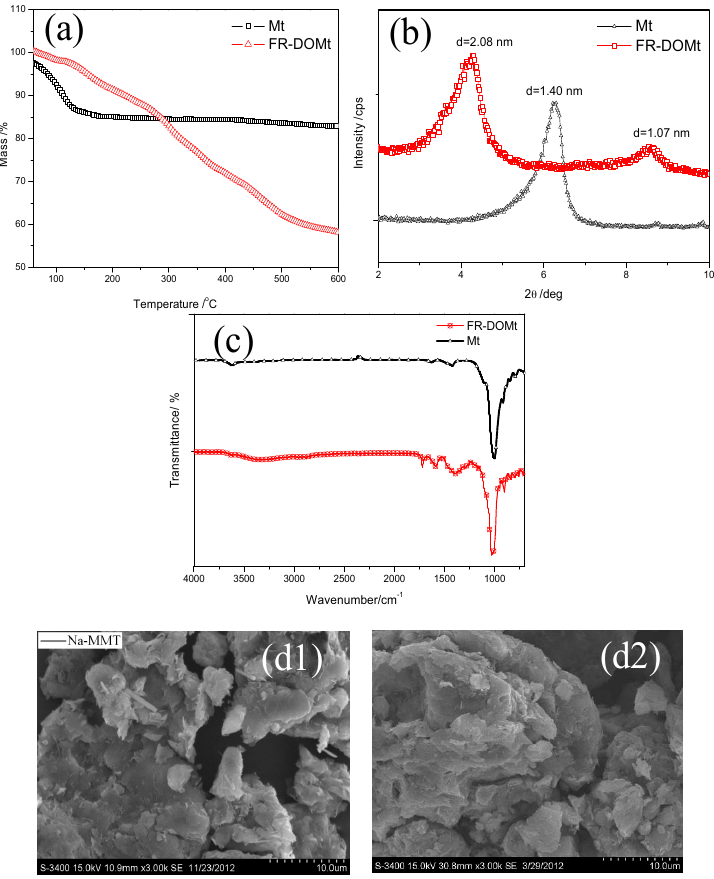
Scheme 1. Preparation process of FR-DOMt.